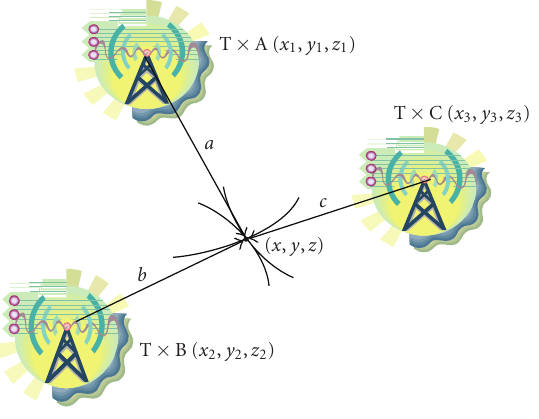
Figure 2: Position location using three